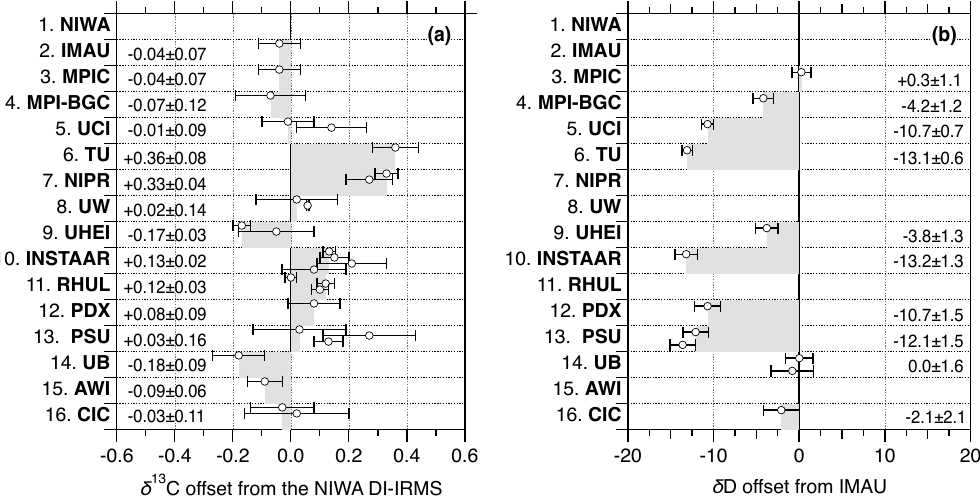
Figure 2. (a) δ 13 C-CH 4 offsets of the different laboratories with respect to the NIWA DI-IRMS measurement with grey shades for ease of viewing. (b) δ D-CH 4 offsets of the different laboratories with respect to the IMAU GC-IRMS measurement. See Table 1 and text for corresponding subsections in Sects. 3 and 5. Numbers shown in each laboratory column are the plausible measurement offsets estimated in this study. Note that this result represents intercomparisons for the modern atmospheric CH 4